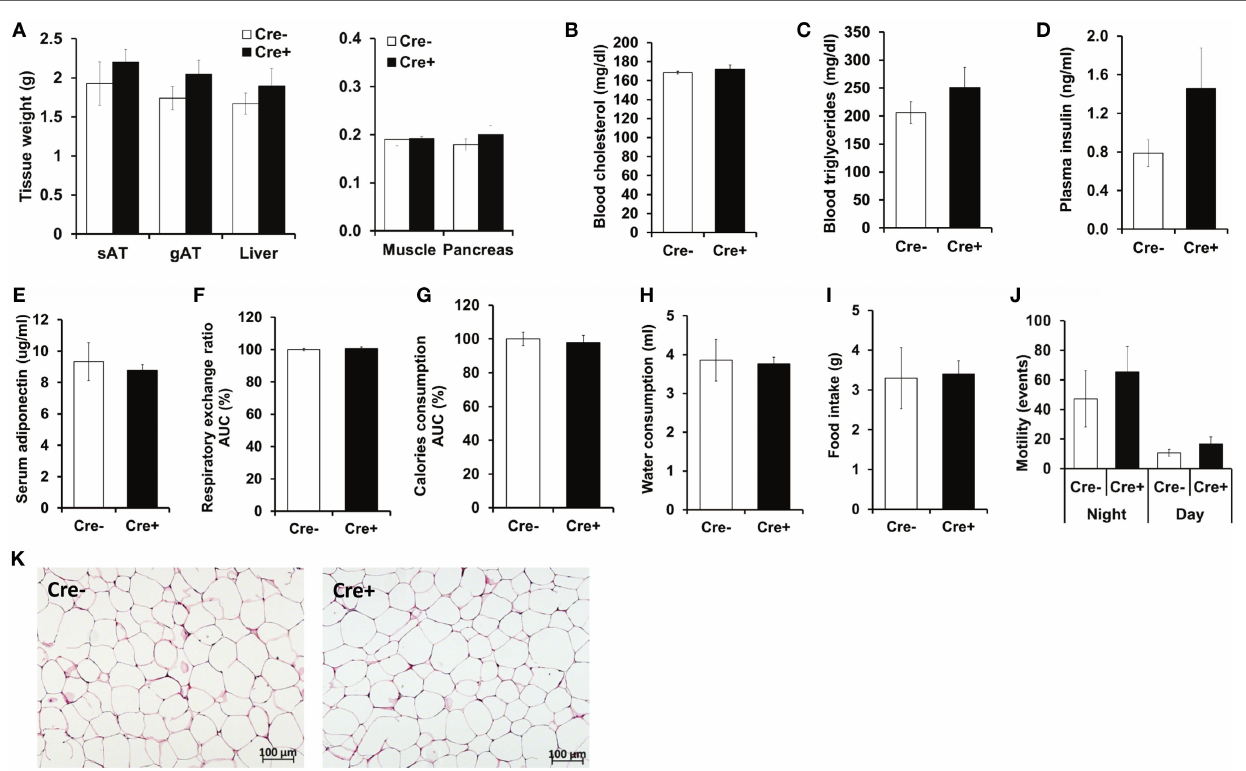
FigUre 2 | no metabolic differences between obese mast cell-deficient and -proficient mice . (a) After 21 weeks on HFD, mice were euthanized and dissected. Tissues were collected, and their weights were recorded. sAT, subcutaneous AT; gAT, gonadal AT. (B,c) Levels of cholesterol and triglycerides in blood were measured after 16 h of starvation in obese mast cell-deficient and -proficient mice. (D) Insulin in the plasma from obese mast cell-deficient and -proficient mice was measured after 16 h of starvation. (e) Adiponectin in serum from obese mast cell-deficient and -proficient mice was measured. (F–J) Metabolic performance of obese mast cell-deficient and -proficient mice was analyzed by using comprehensive laboratory animal monitoring system (CLAMS) for three consecutive days and nights. (F) Respiratory exchange ratio (RER); data are shown as area under curve (AUC) of the experimental period (3 days and 3 nights together). AUC data are presented as % of control; the Cre-negative group was set as the 100% control. (g) Calories consumption; data are shown as area under curve (AUC) of the experimental period (3 days and 3 nights together). AUC data are presented as % of control; the Cre-negative group was set as the 100% control. (h) Cumulative water consumption at the end of the experimental period (3 days). (i) Cumulative food intake at the end of the experimental period (3 days). (J) Mouse motility (events/20 min) during light and dark period of the three consecutive days and nights was measured by recording motion events with infrared motion sensor. (K) Morphology of the gonadal AT from obese mast cell-deficient and -proficient mice was performed with hematoxylin/eosin staining; representative images are shown. Student’s t -test (a–e) and ANCOVA (F–J) with animal body weight as covariant were used for statistical evaluation, n = 8–10 mice [in (a–e) ] and n = 4 mice/group [in (F–J) ]. Data are expressed as means ±